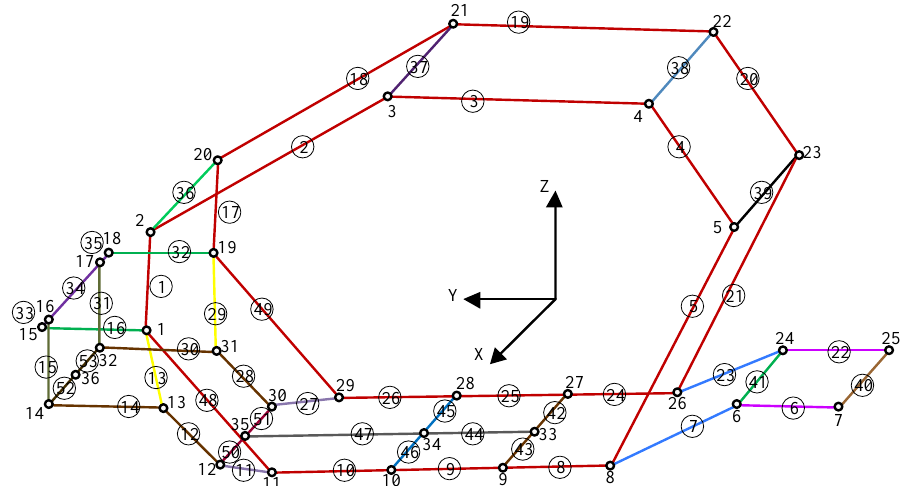
Figure 3. The mathematic simulation model of BIW conceptual structure.